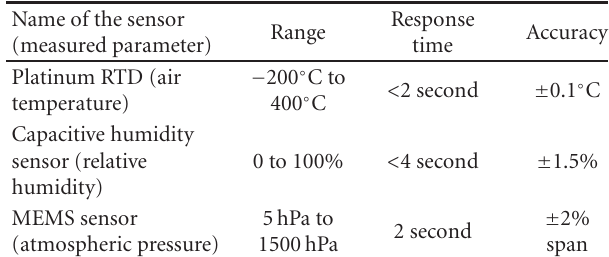
Table 1: Technical details of Pisharoty GPS Sondes (Make: VSSC, ISRO,